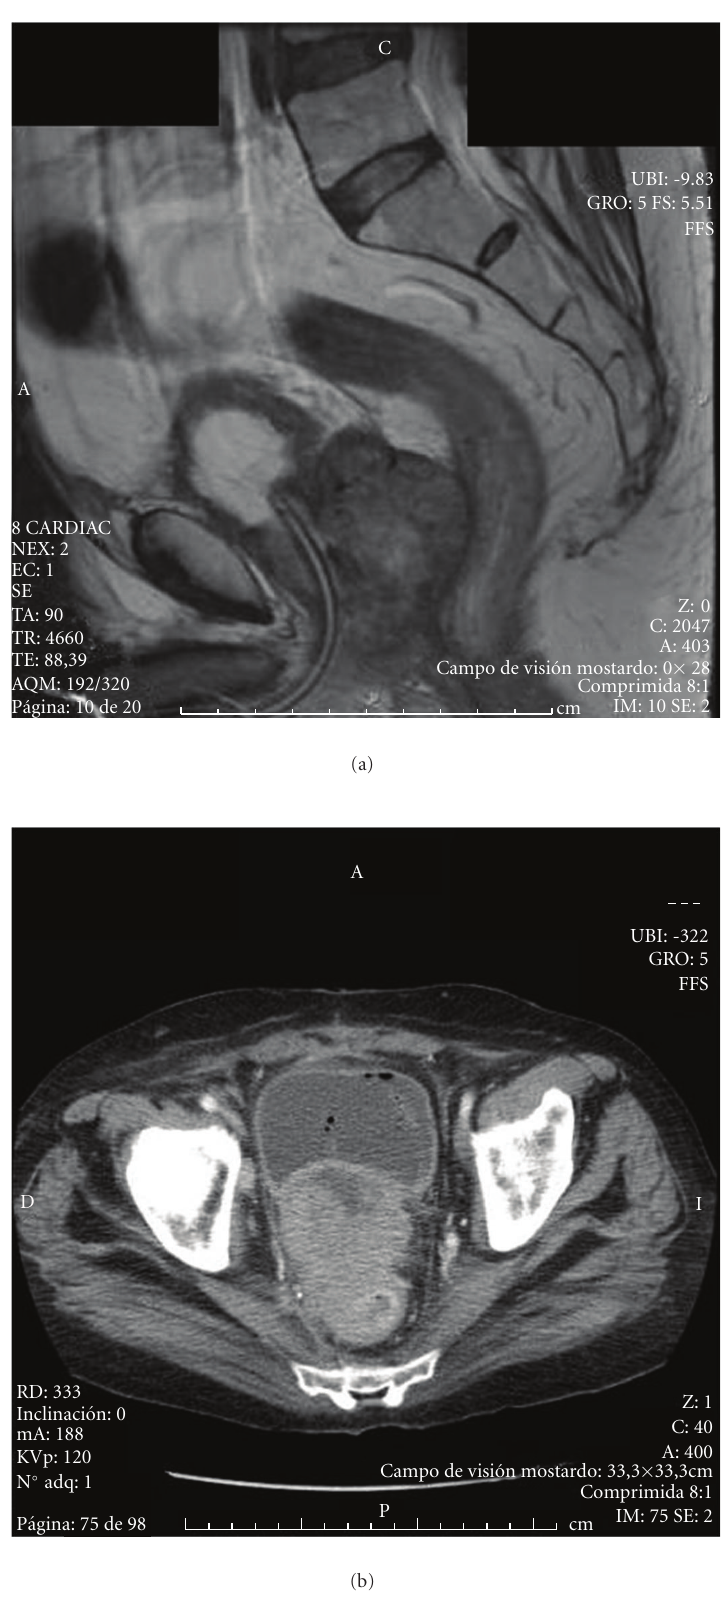
Figure 1: (a) Pelvic MRI considered suspicious for extracapsular extension of the tumour. (b) Pelvic TC scan showed tumour with extents hypodense zones, consistent with